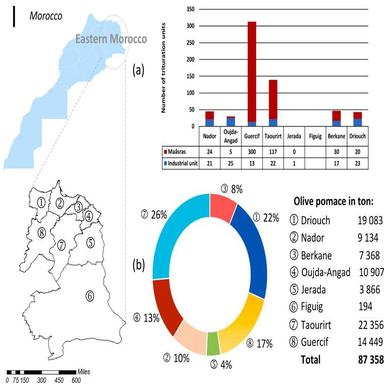
(a): Number of trituration units per province (Eastern); (b): Distribution of olive pomace production.